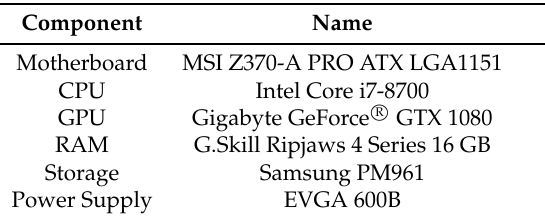
Table 1. PC components.